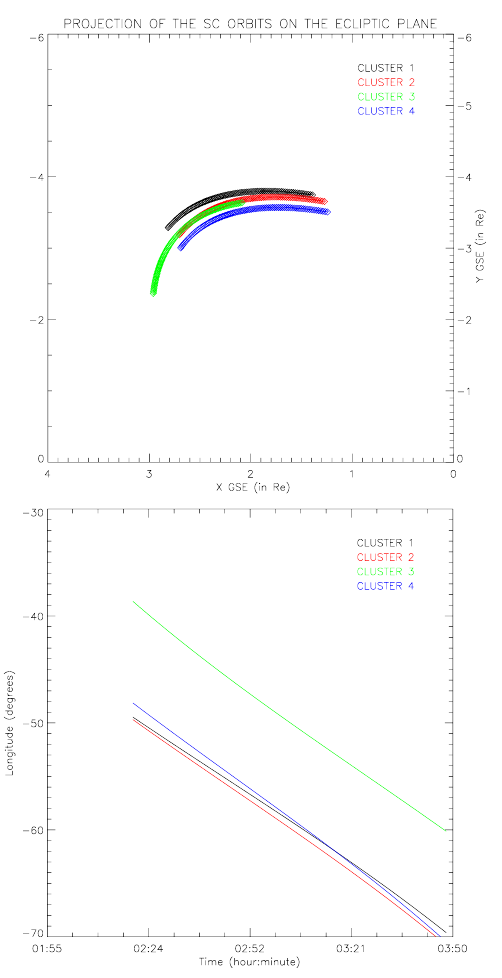
Fig. 3. The top panel represents the projection of the SC orbits in the ecliptic plane, whereas the bottom panel shows the correspond- ing azimuthal angle (longitude) as a function of time in the interval 02:19:30–03:48:30UT. The curves are colour-coded according to each SC.